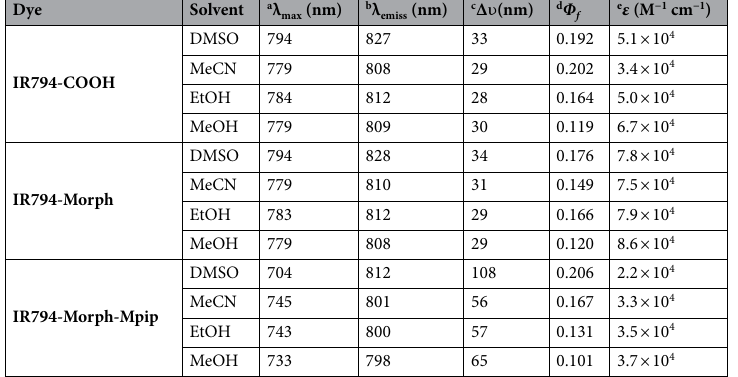
Table 1. The photophysical properties of IR794 (1–3) in the different solvents. a λ abs = absorption maximum wavelength, b λ em = emission maximum wavelength (Excitation wavelength = 750 nm), c ∆λ = stokes shifts (λ em − λ abs ), d Φ f = fluorescence quantum yields calculated by using Indocyanine green (ICG) was used as a standard ( Φ = 0.13 in DMSO), e ε = molar